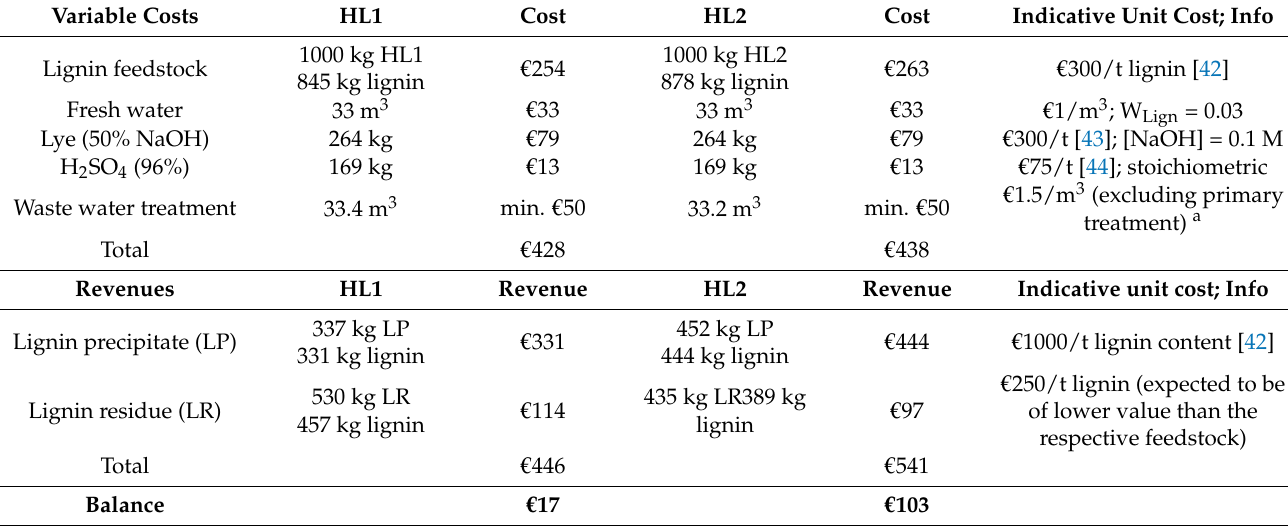
Table 2. Required input and output for the alkaline hydrolysis-acid precipitation of one metric ton hydrolysis lignin and an estimation of associated costs and